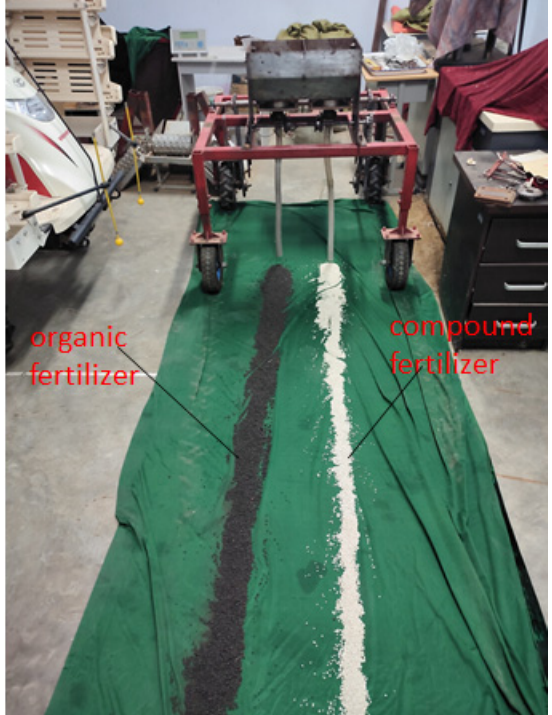
Figure 12. Verification test site map.